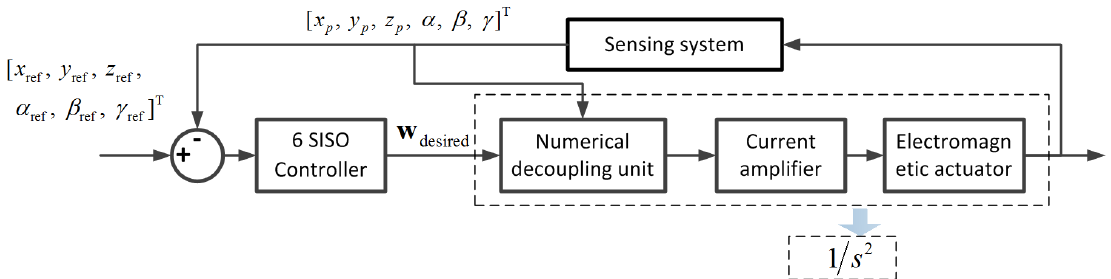
Figure 3. Control block of the magnetic levitation rotary table with force and torque decoupling unit. SISO—single-input